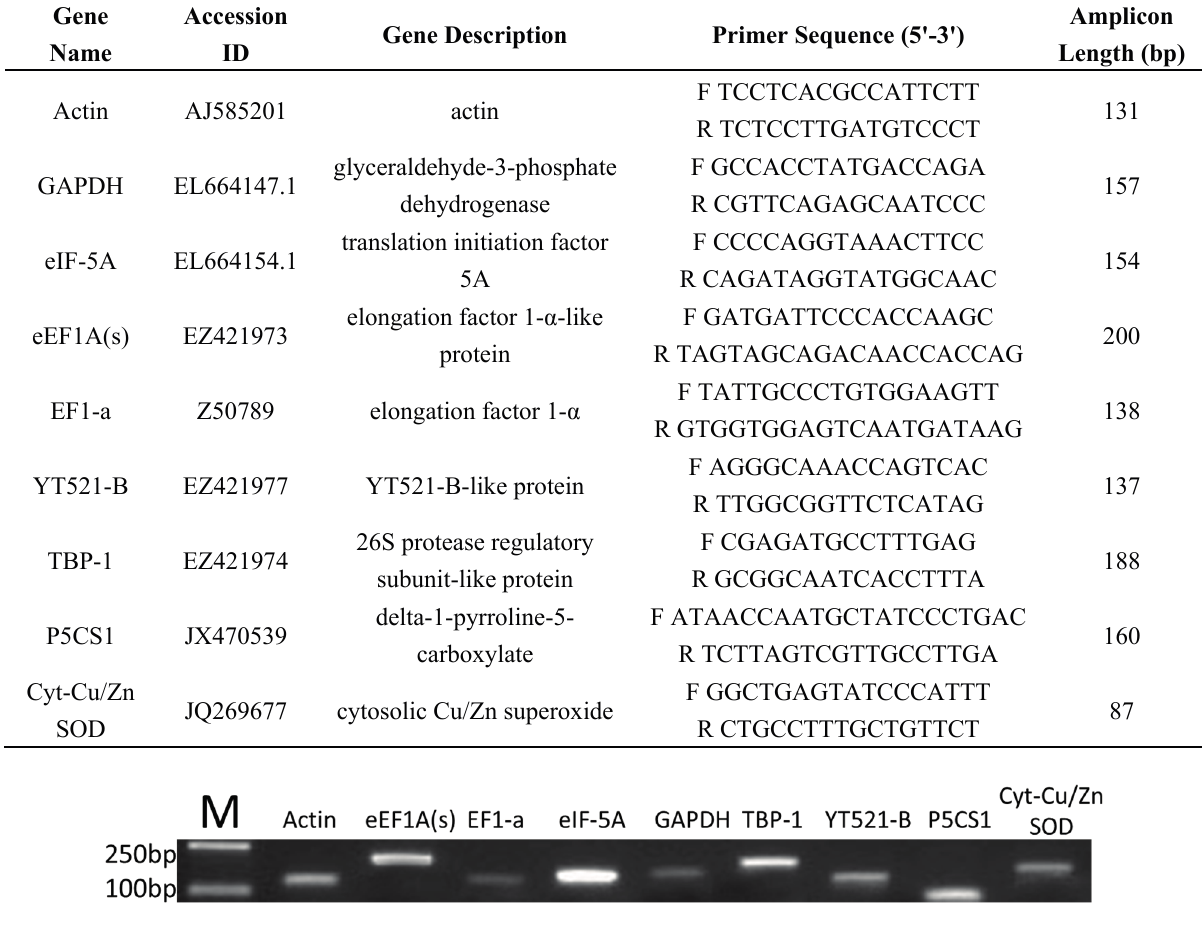
Figure 1. Specific PCR products of nine candidate